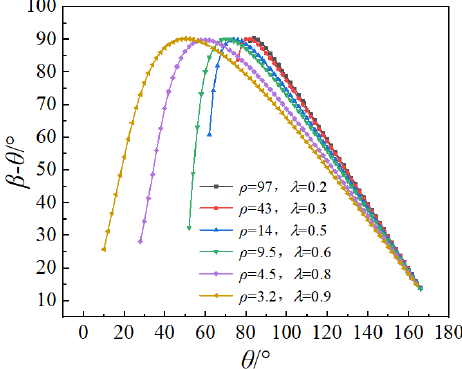
Figure 10. The curves under different parameter matching.